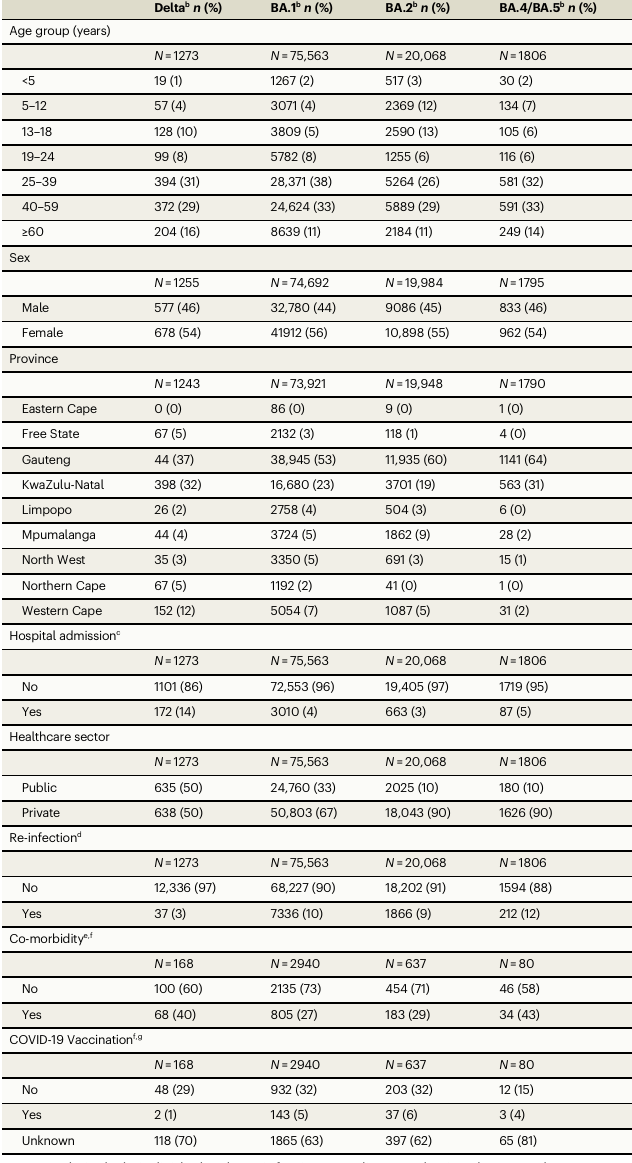
Table 1 | Characteristics of individuals infected with SARS- CoV-2 by variant/lineage type, 1 October – 26 April 2021